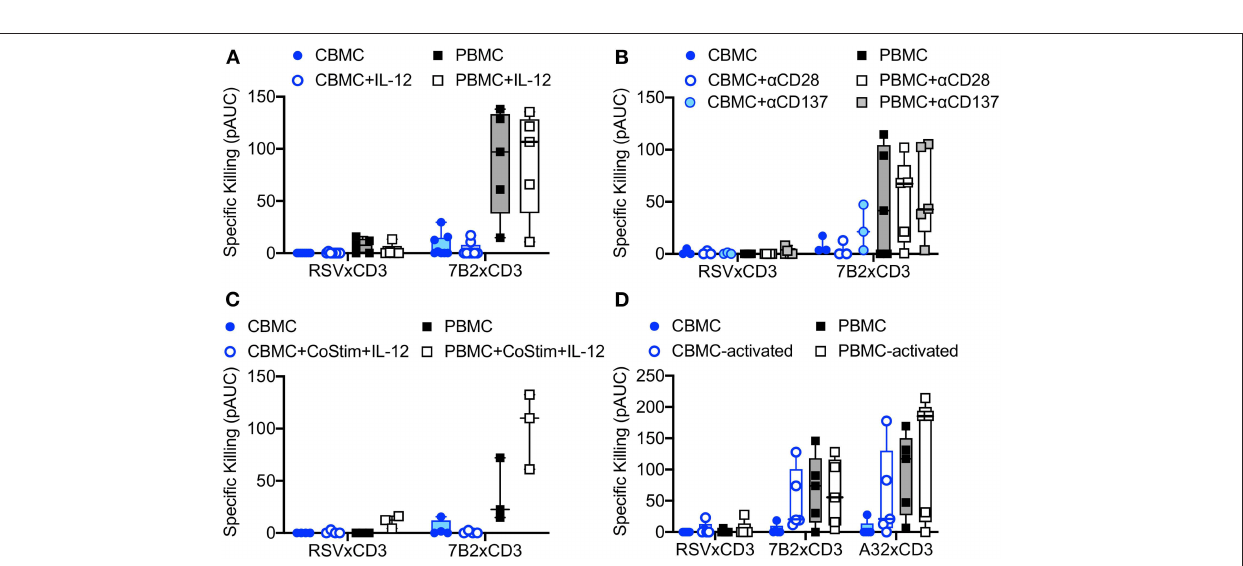
FIGURE 2 | Cells and CD4 + T cell subsets or (E) CD8 + T cells and CD8 + T cell subsets in CBMC ( n = 14) and adult PBMC ( n = 5). In (D,E) , box plots represent the interquartile ranges, horizontal lines indicate the medians, and error bars extend to the minimum and maximum observed values. (F) CD8 + T cells subsets that degranulate concomitant with HIV × CD3 or control (RSV × CD3) DART molecule mediated cytolytic activity. Rows represent assay results using PBMC from two different adult donors, Dn1 and Dn2. Distribution of CD8 + T cell subsets is shown in the first column. Red dots in the remaining columns represent CD8T cells that have degranulated (CD107a + ) in response to the indicated DART molecules (frequencies within each quadrant indicated with red text), overlaid on the total CD8 + T cells (gray dots) acquired for each condition. 24h killing assay with a CD8 + effector to Bal-infected autologous CD4 + target cell ratio of 30:1 and DART molecule concentration of 100ng/mL.